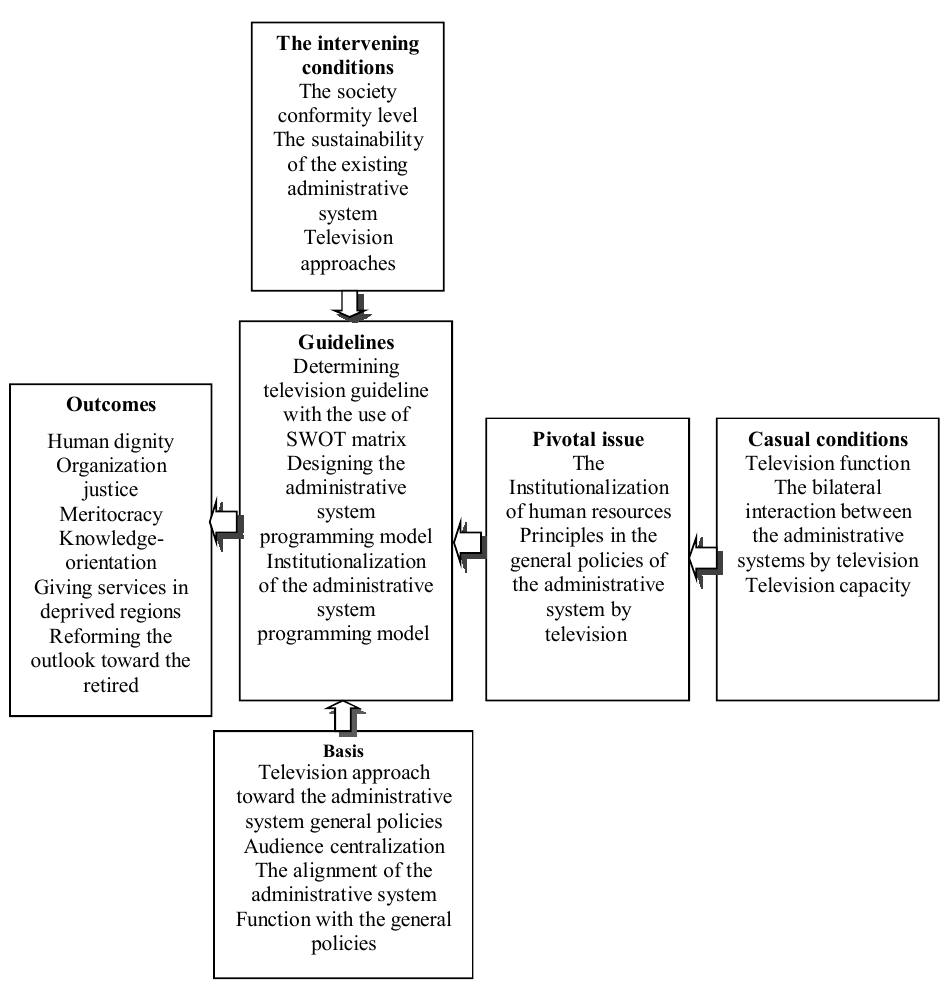
Fig. 2. The axial encoding model: The Institutionalization of human resource principles in the general policies of the administrative